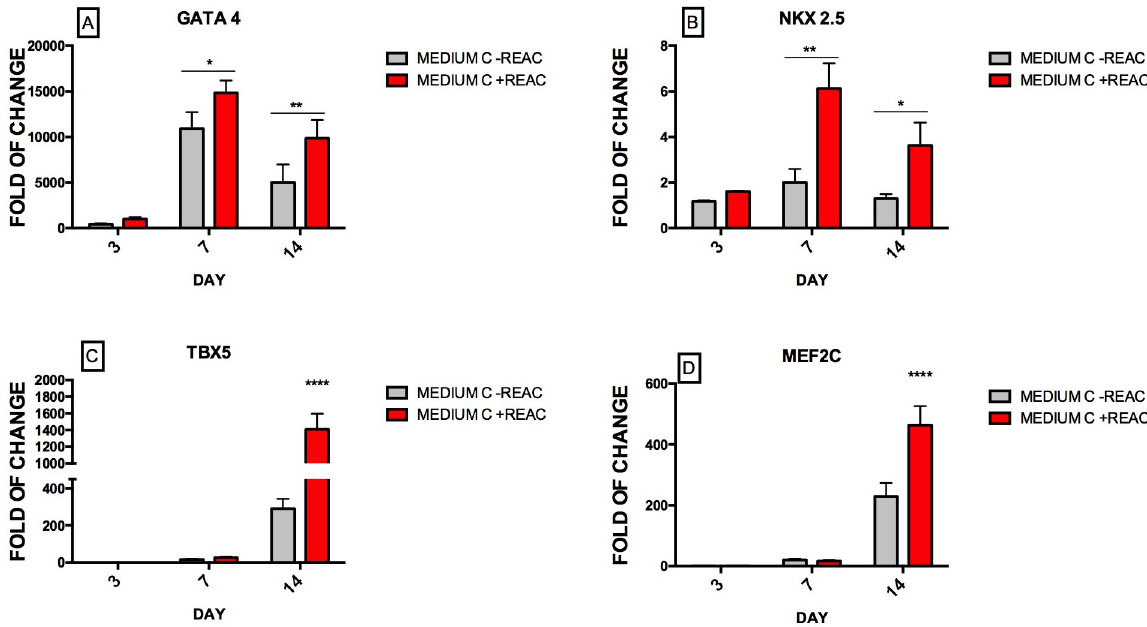
Fig 3. Effect of REAC treatment on the expression of cardiogenic transcripts in hUiPSCs supplemented with defined medium. Cells cultured in cardiogenic conditioned medium (Medium C) were exposed for 72 h, in the absence (grey bars) or presence (red bars) of REAC and then cultured in the presence of medium C alone until day 14th. The amount of GATA4 (A), Nkx-2.5 (B), Tbx5 (C) and Mef2C (D) mRNA from untreated (grey bars) or REAC-treated (red bars) cells was normalized to glyceraldehyde 3-phosphate dehydrogenase (GAPDH) and was plotted as fold of change relative to the mRNA expression in hUiPSCs at day 0. Data shown mean ± S.D; n = 4 (P < 0.05 �� ), (P < 0.001 � �� ).